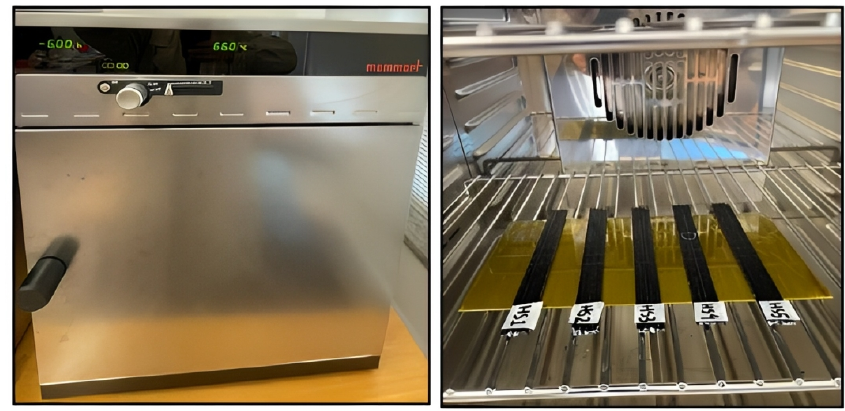
Figure 2. An air-circulated oven for hot temperature treatment.